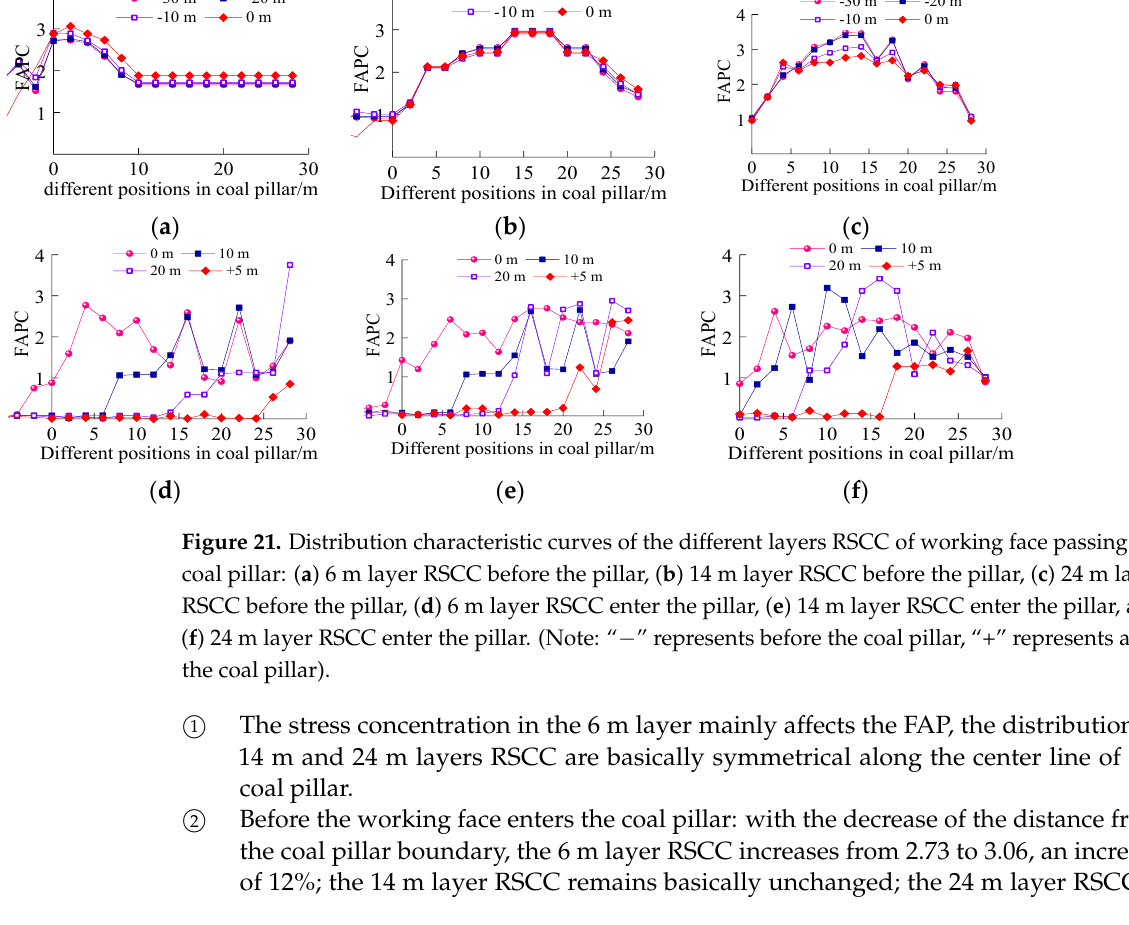
Figure 21. Distribution characteristic curves of the different layers RSCC of working face passing the coal pillar: ( a ) 6 m layer RSCC before the pillar, ( b ) 14 m layer RSCC before the pillar, ( c ) 24 m